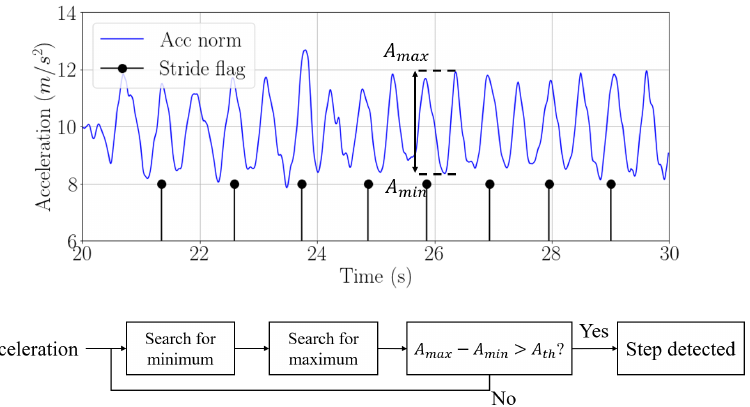
Figure 8. Norm of acceleration (blue) and detected strides (black) when the passenger carries the smartphone in the hand and algorithm for step